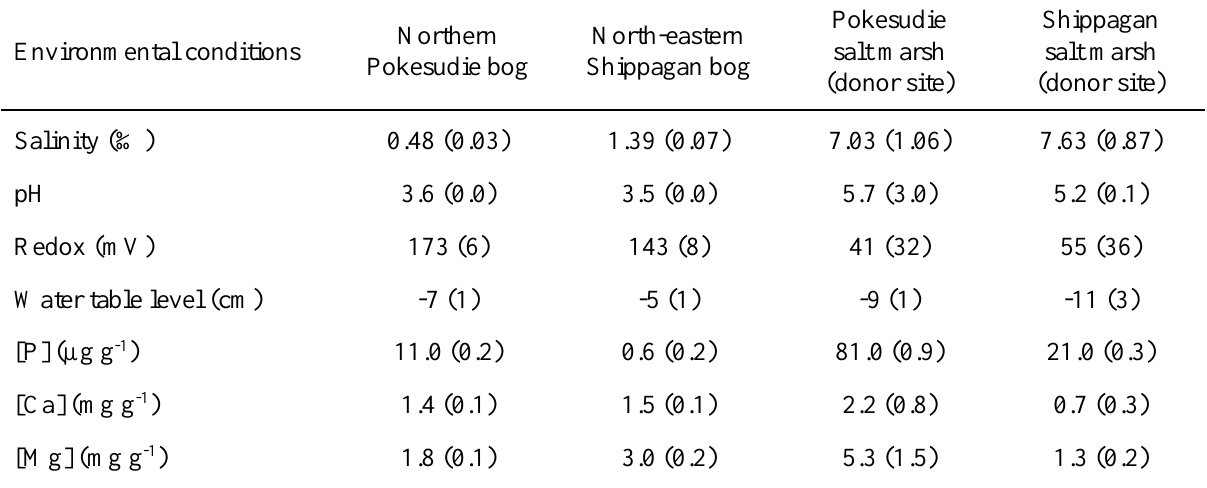
Table 1. Soil environmental conditions in sections of the seawater-contaminated Pokesudie and Shippagan peatlands and in the nearby salt marshes where plant material was collected (donor sites). P, Ca and Mg concentrations are included to show how the soils differed with respect to these nutrients before fertiliser additions aiming to increase nutrient availability. The values are means with (SE) in